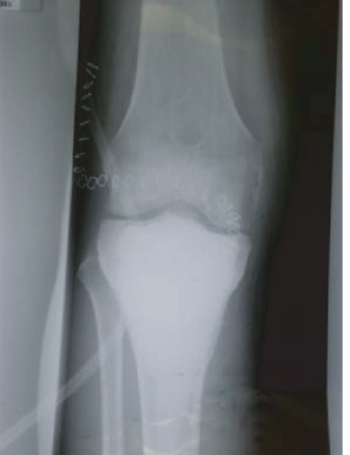
Figure 5: Postoperative AP view of the left knee.